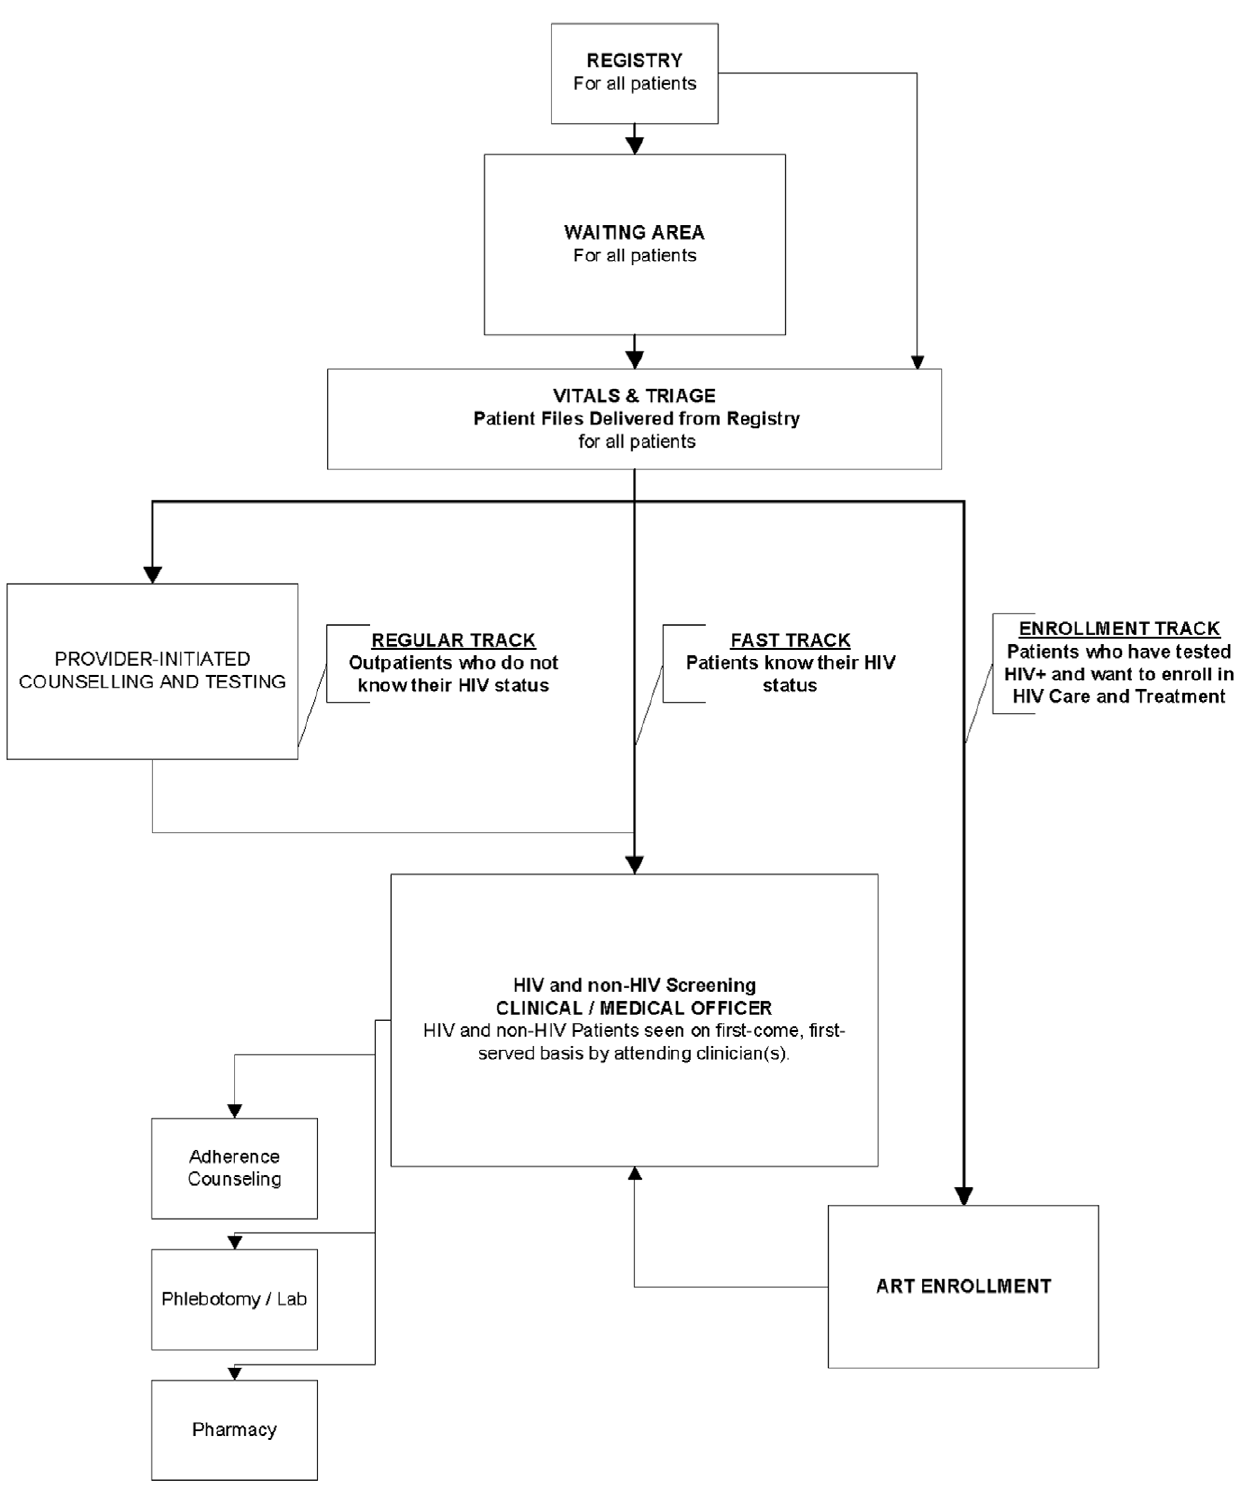
Figure 1. Integrated patient flow.